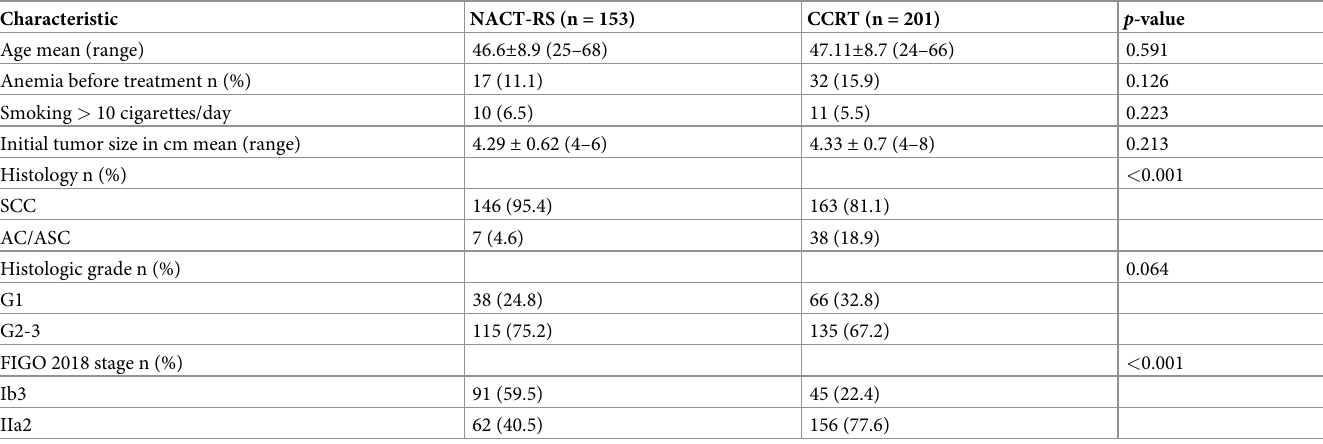
Table 1. Patient and tumor